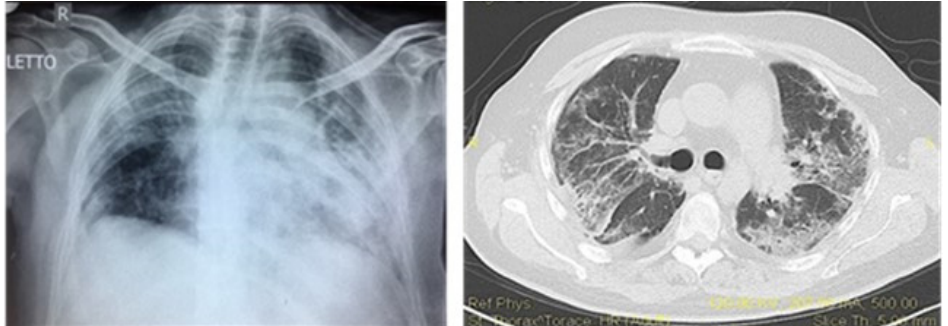
Figure 5. Diffuse alveolar hemorrhage. A chest radiography shows bilateral widespread infiltrates in both medium lower fields. A chest computed tomography shows left pulmonary embolism and massive diffuse infiltration of both lung fields. R means right.